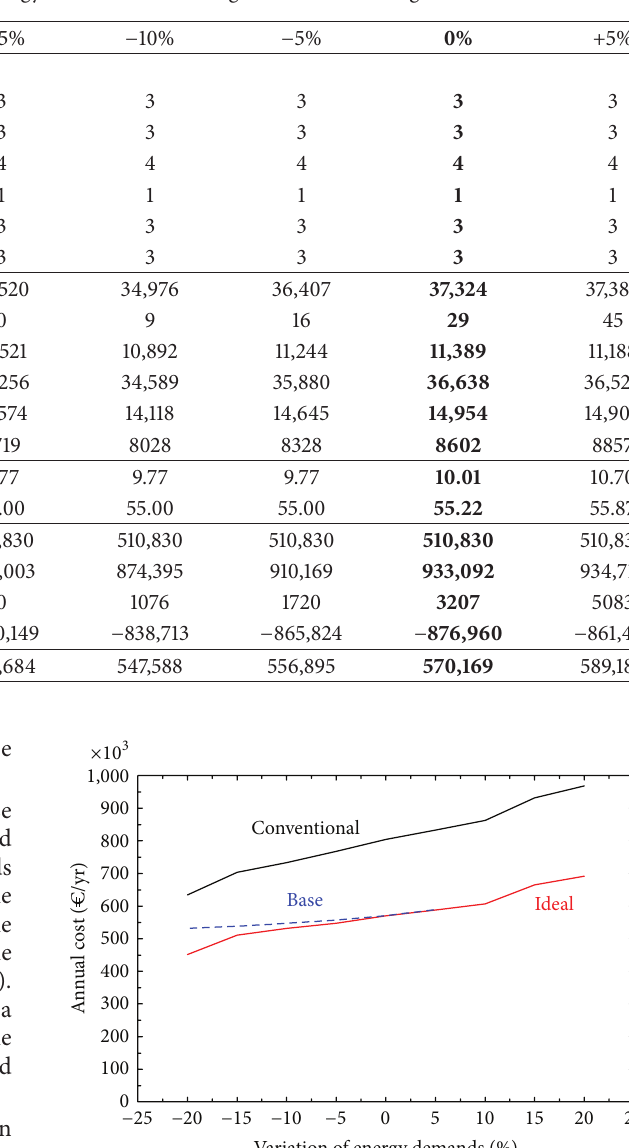
Table 4: Sensitivity analysis for variations in energy demands considering the base case configuration.